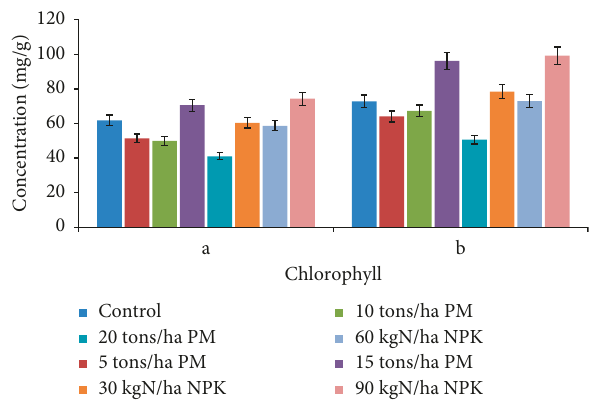
Figure 2: Effect of different rates of chicken manure and NPK fertilizers on chlorophyll contents of Table 7: Proximate constituents of sunflowers as influenced by different rates of chicken manure and NPK fertilizers. Treatments